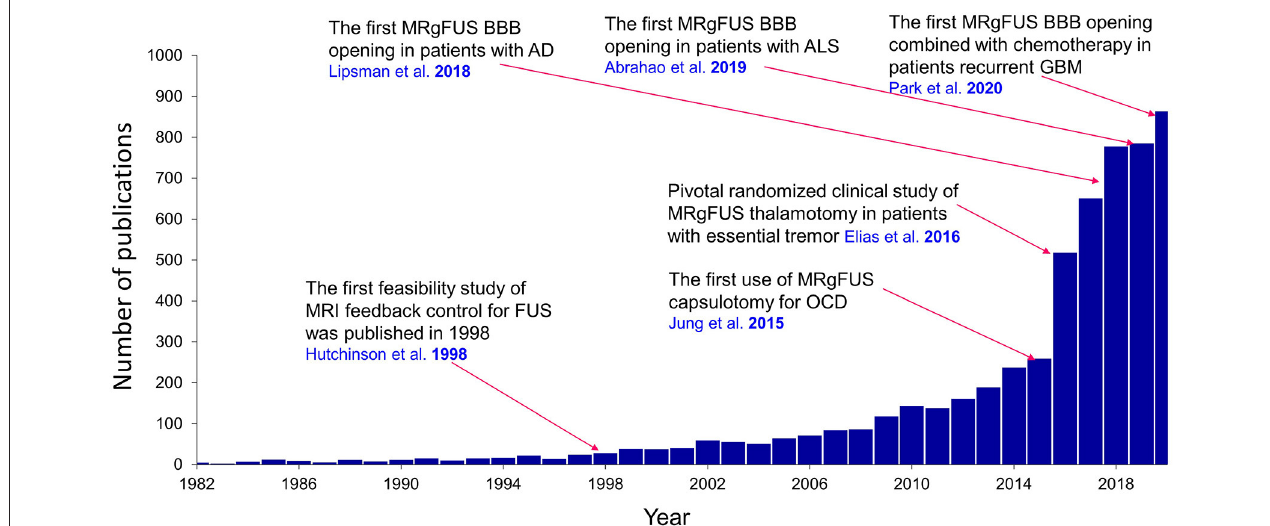
FIGURE 2 | Publications regarding the clinical application of FUS in neurological disorders. A landmark study for each clinical application is overlaid on the graph. Results were obtained from PubMed. AD, Alzheimer’s disease; ALS, amyotrophic lateral sclerosis; BBB, blood-brain barrier; GBM, glioblastoma multiforme; OCD, obsessive-compulsive